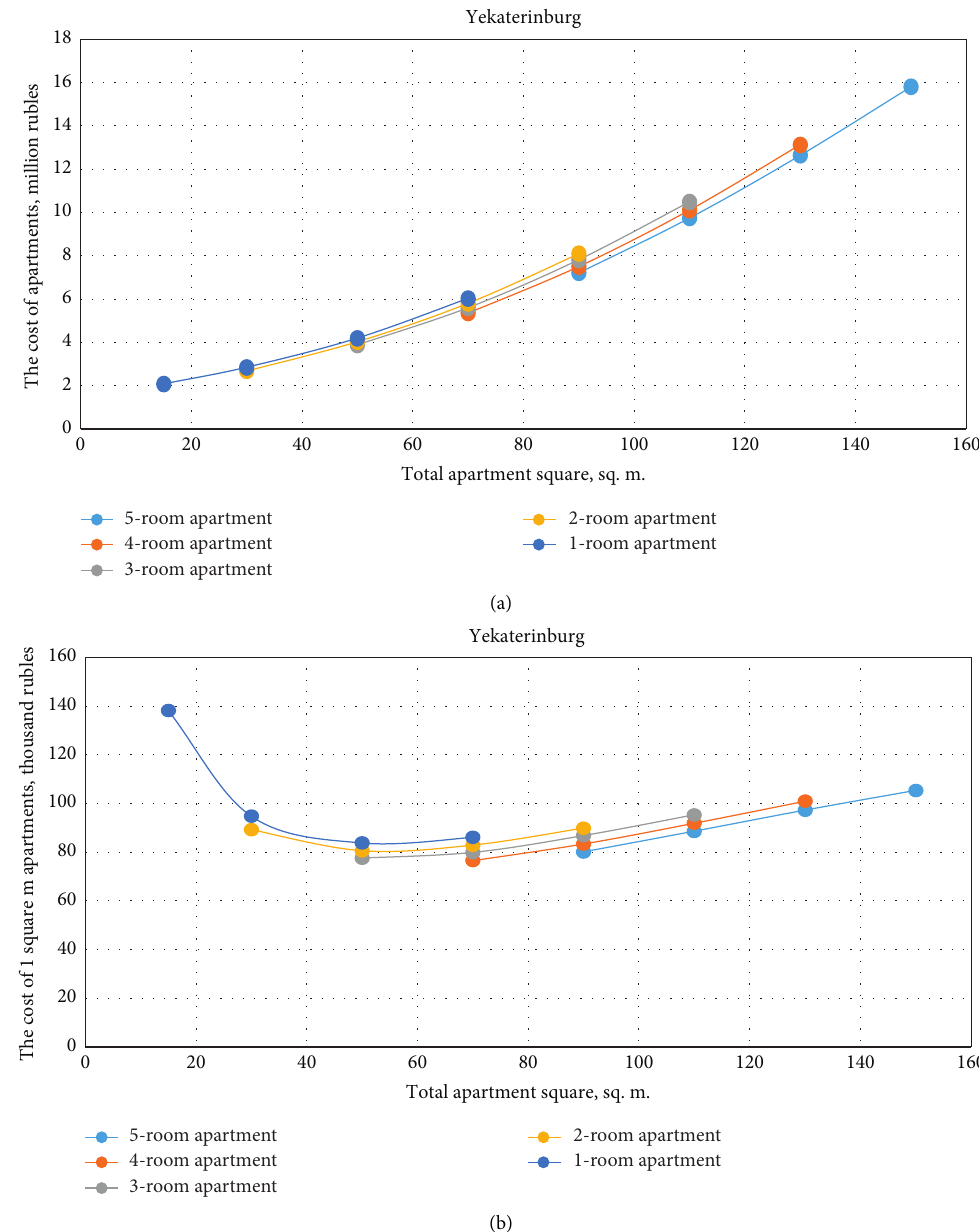
Figure 6: Influence of the square area of Yekaterinburg apartments on their cost (a) and on the specific cost of one square meter